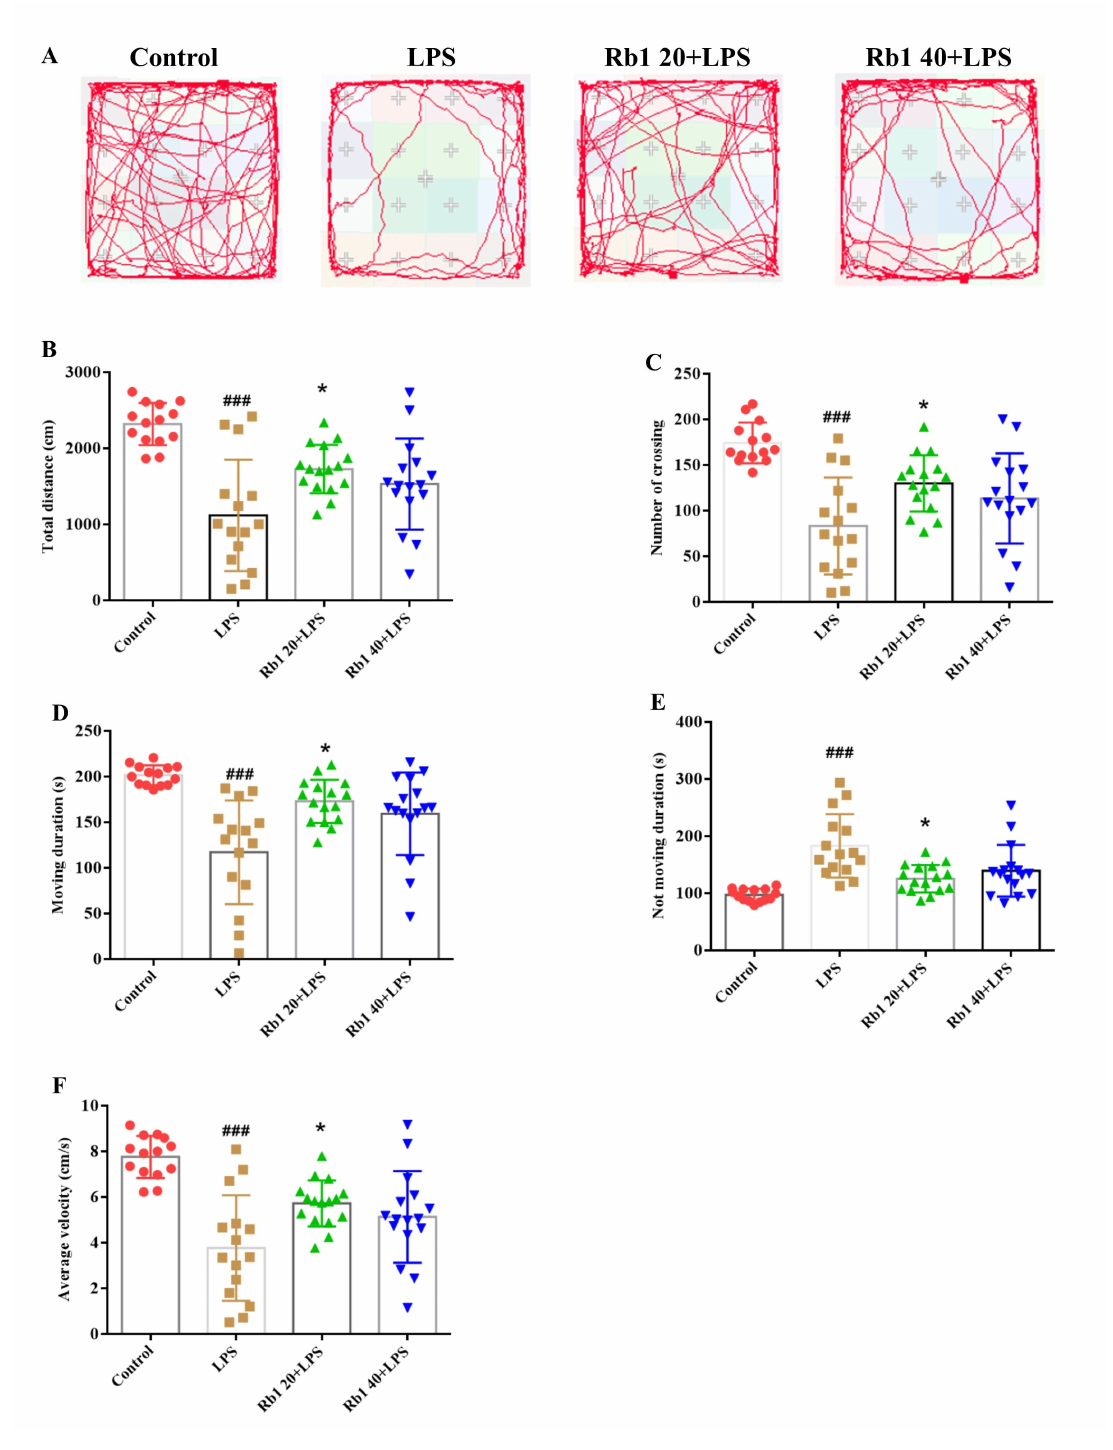
Fig. 2. Rb1 improved the locomotive activities in LPS-treated mice. The locomotive activity was monitored using the open-field test between 20 h and 24 h after the LPS injection. The track maps of different groups (A), and quantitative analysis of total distance, crossing lines, moving and stand still duration, average velocity during 5 min (B–F) are listed. Data are represented as mean ± SD (n = 20). ### p < 0.001 versus the control group; * p < 0.05 versus the LPS